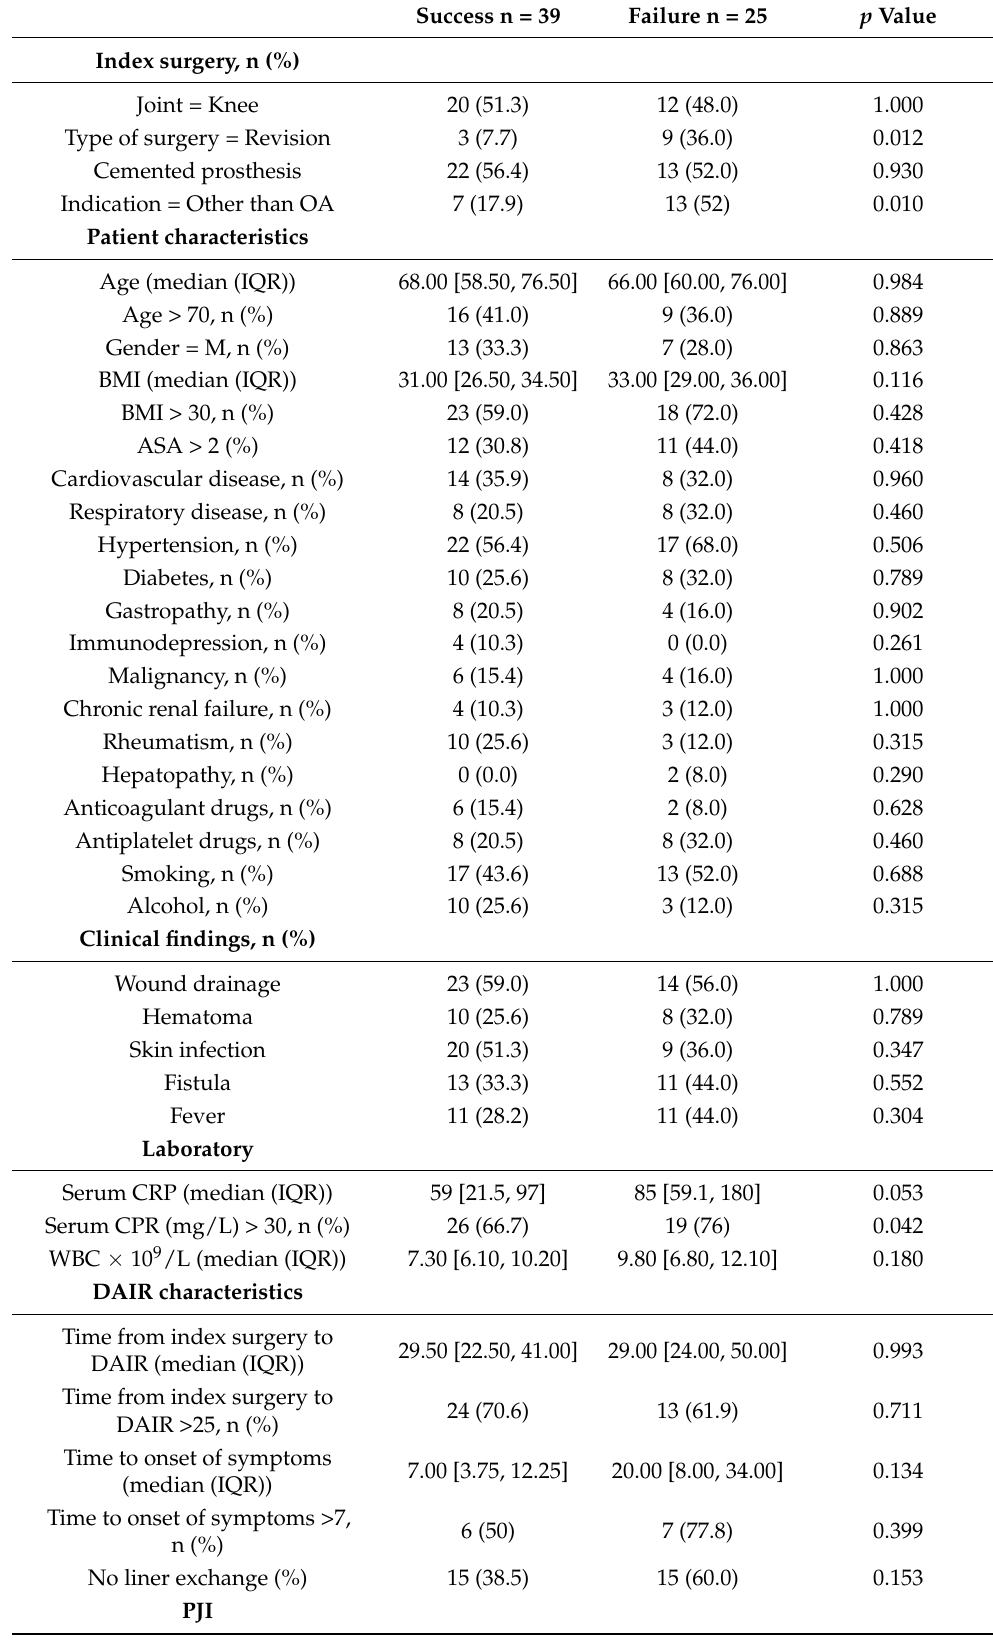
Table 1. Predictors and frequencies according to the final outcome (DAIR success vs.